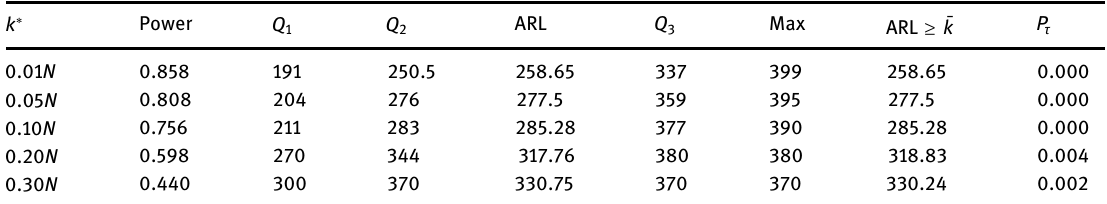
Table 3: Conditional powers, average of run lengths and probability of false alarms for score test with ( ) = g s c s under H A